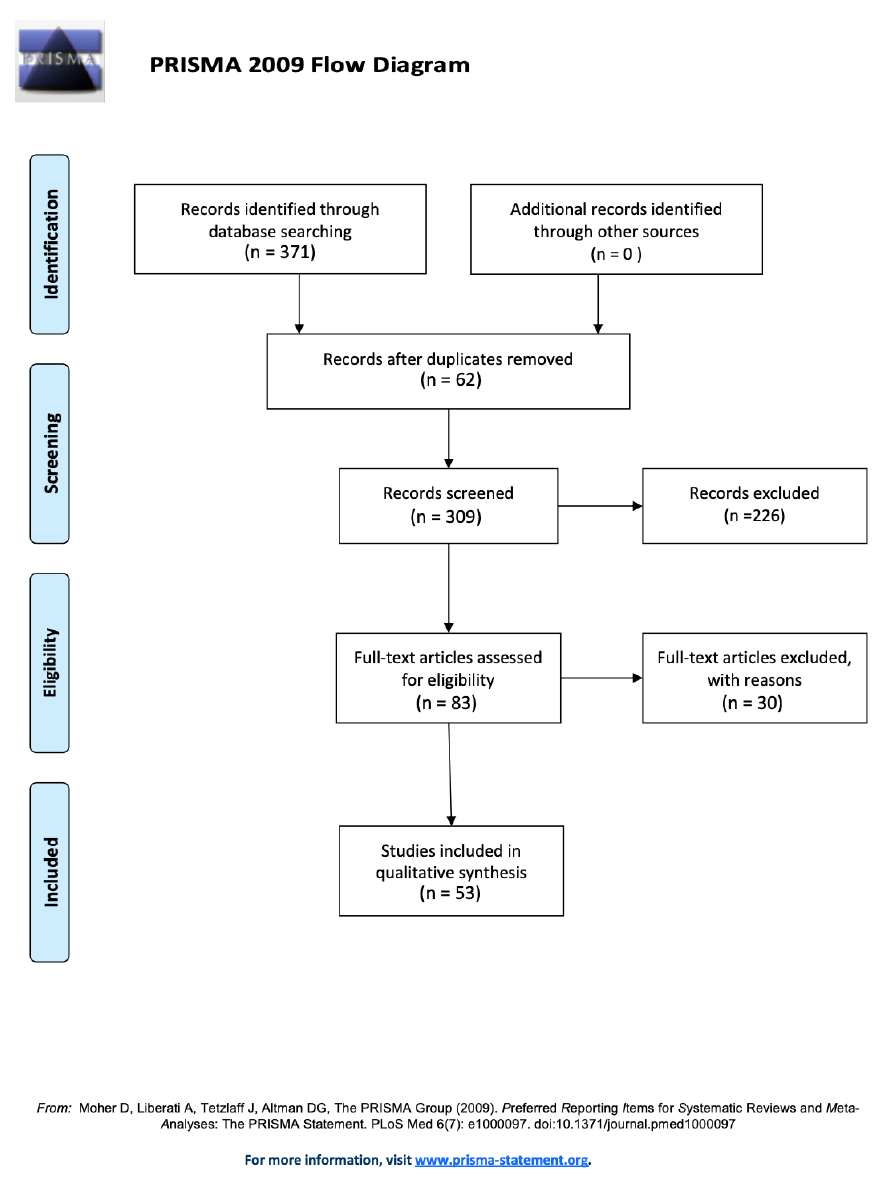
Figure 1. A PRISMA flow chart of the pooled